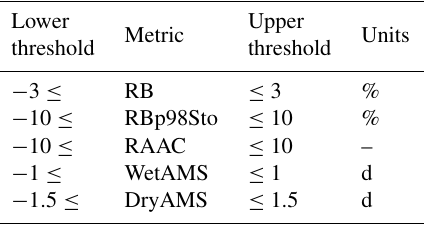
Table 2. Conditions applied to the median validation metric values of the transfer functions for further